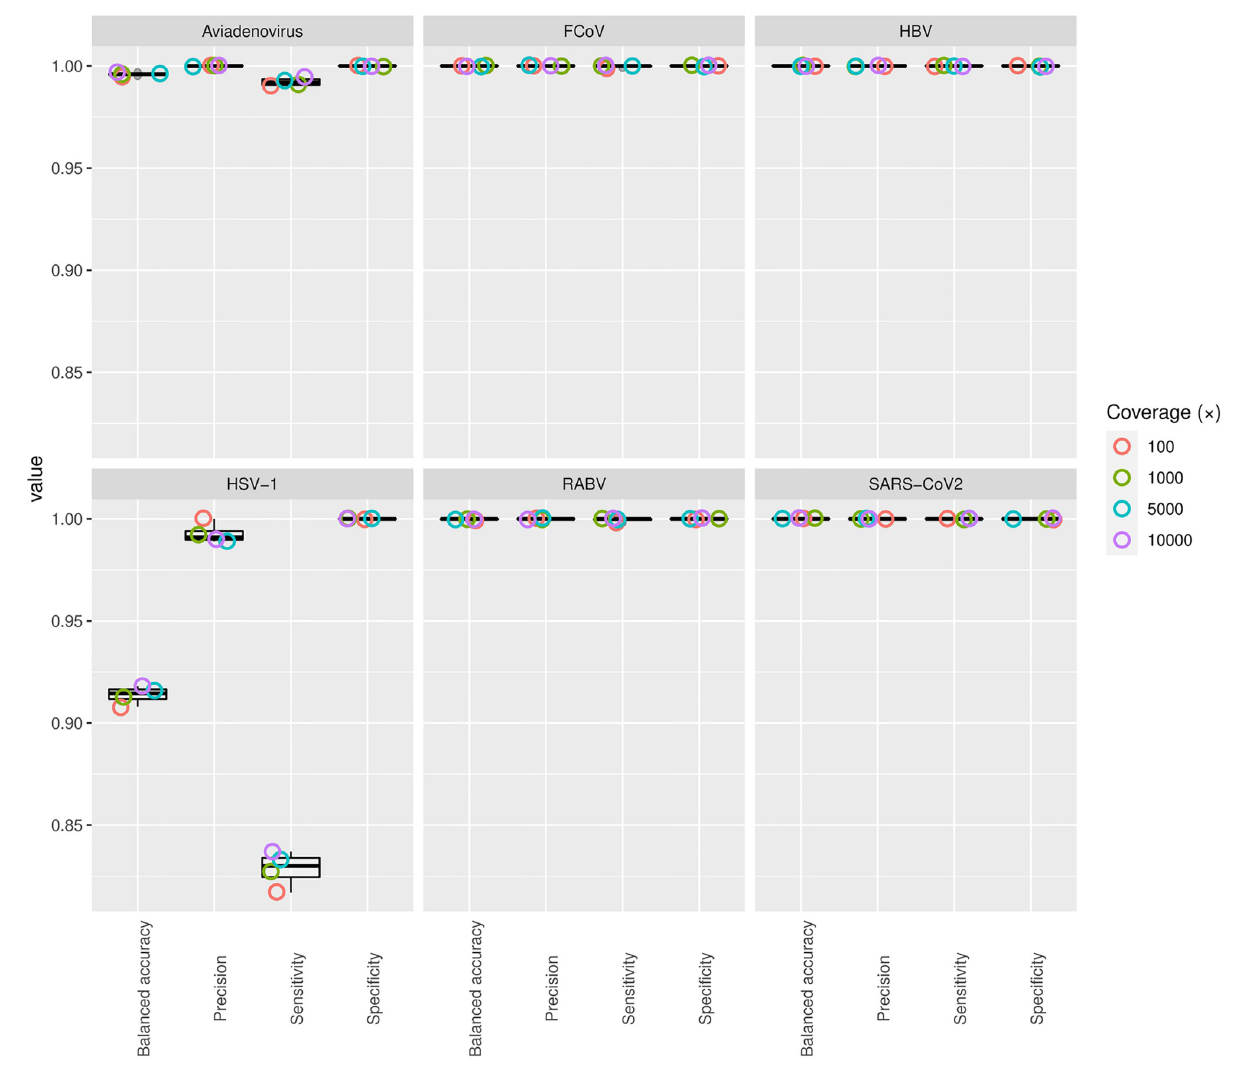
Fig 2. Statistical assessment of the presented pipeline’s accuracy. The plots show the values of sensitivity (true positive rate—TPR), specificity (true negative rate—TNR), balanced accuracy (BA), and precision (positive predictive